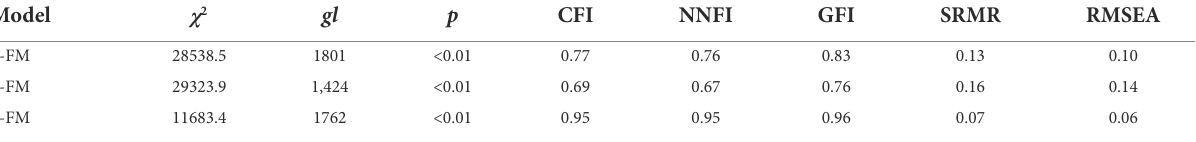
TABLE 5 Values of fit indexes in different underlying models of the IIA-PRF.